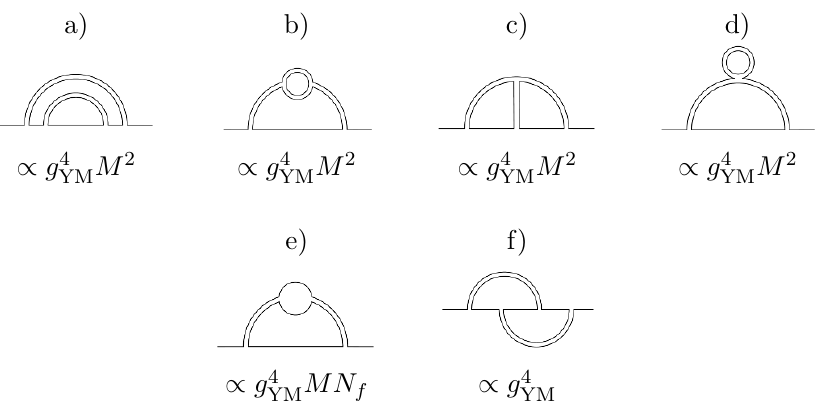
Figure 5 . 2-loop diagrams contributing to the quark self-energy with their relative